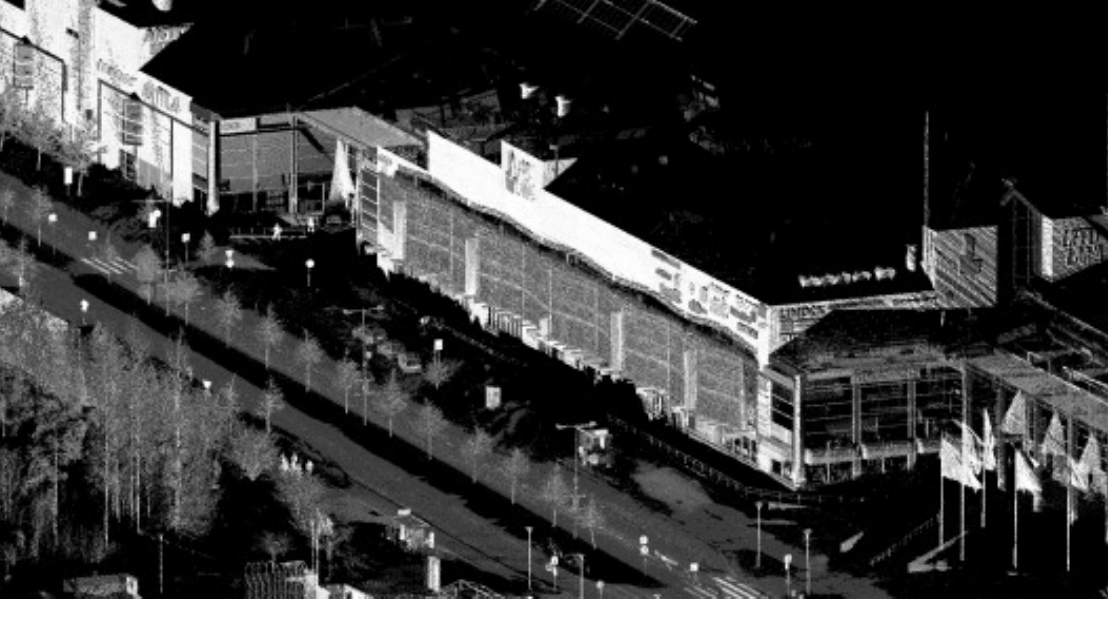
Figure 8. ROAMER